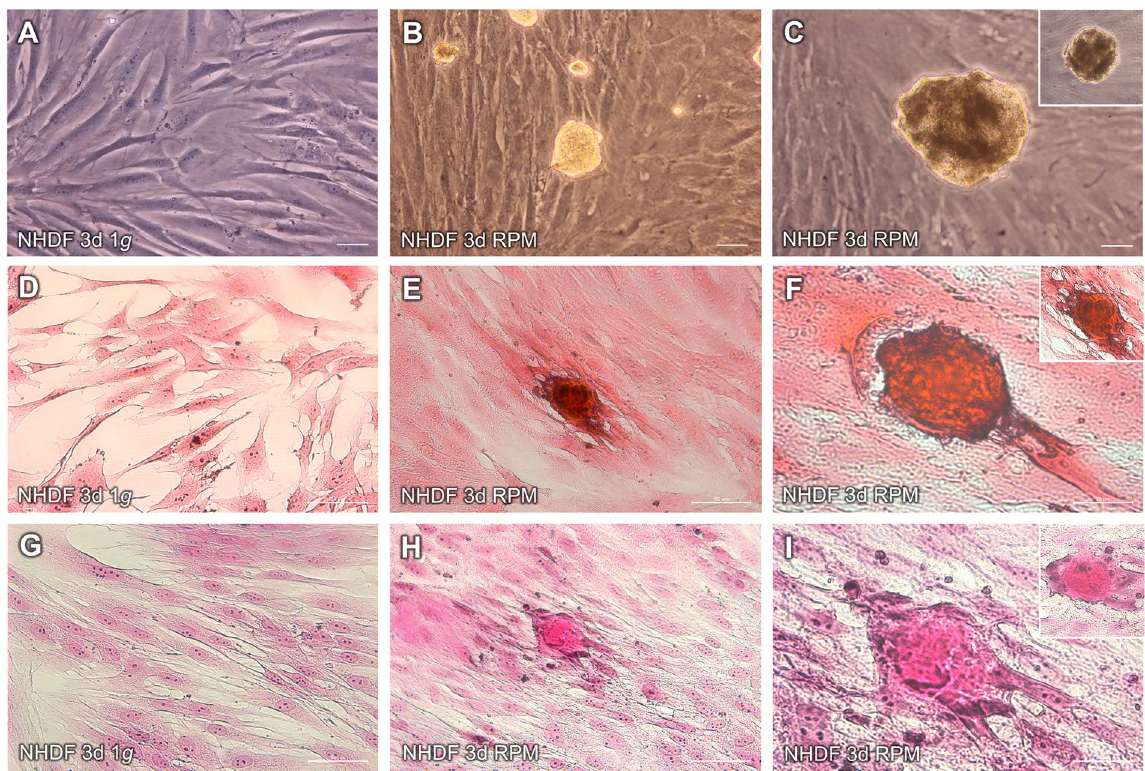
Figure 1. Characterization of morphological alterations in juvenile NHDF cells after a three-day RPM- exposure. Phase contrast microscopy images of 1 g -control cells ( A ), RPM-AD ( B ) and RPM-MCS ( C ). Hematoxylin-Eosin staining of 1 g -control cells ( D ), RPM-AD ( E ) and RPM-MCS ( F ). Elastica van Gieson staining of 1 g -control cells ( G ), RPM-AD ( H ) and RPM-MCS ( I ). Scale bars: 50 µ